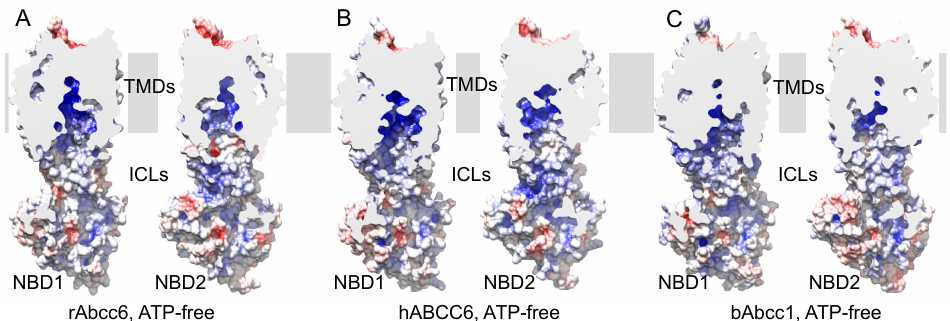
Figure 1. Electrostatic potential of the inward-facing state of hABCC6/rAbcc6 and bAbcc1. Electro- static potential mapped on the molecular surface of the ATP-free, inward-facing ( A ) rAbcc6 model, ( B ) hABCC6 model, and ( C ) bAbcc1 cryoEM structure. The isovalue was set at − 10 k B T/e for the negative potential (red) and +10 k B T/e for the positive potential (blue). For each transporter, the surface is clipped, and the two halves are shown side by side. The region of the transporters embedded in the membrane is highlighted by the gray slab. TMDs, transmembrane domains; ICLs, intracellular loops, i.e., the intracellular extension of the TMDs; NBD1 and NBD2, nucleotide binding domain 1 and 2.